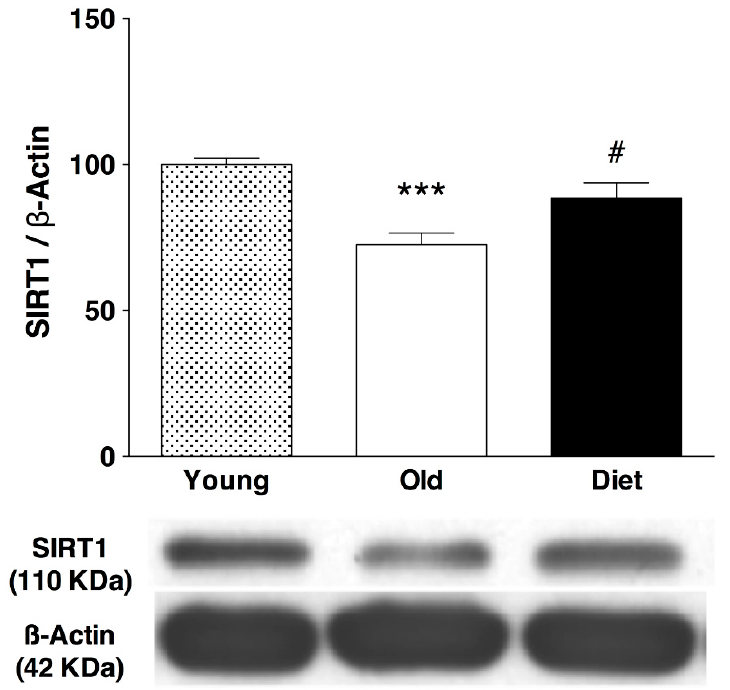
Figure 4. Western blot analysis of hippocampal levels of SIRT1 after an antioxidant-enriched diet in aged rats (20 months) and comparison with young rats (3 months) . Bars represent mean ± SEM of protein levels expressed as percentage relative to the young group. Below graph a rep- resentative immunoblot is shown. Protein level was normalized to β -actin content and each sample was analyzed in three different membranes. One-way ANOVA followed by Bonferroni post-hoc test was used for statistical analysis. One-way ANOVA detected statistical differences between the groups F(2,18) = 14.02, p = 0.0002; *** p < 0.001 when compared old control ( n = 7) and young control animals ( n = 7). # p < 0.05 when compared old animals fed with the antioxi-dant-enriched diet ( n = 6) with old control